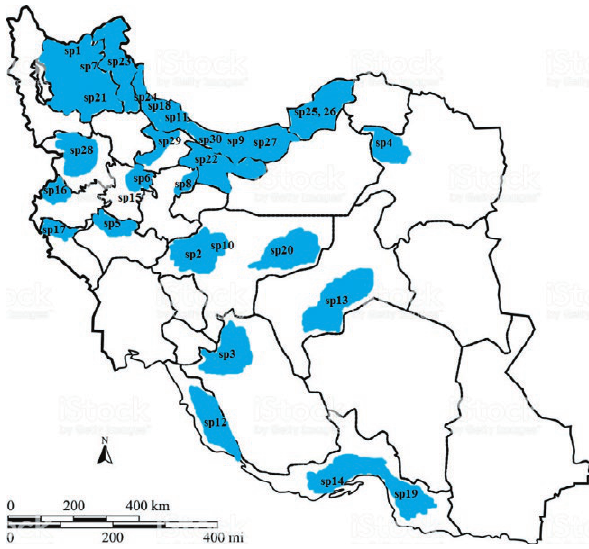
Figure 1. Map of Iran showing sampling localities for Salvia . sp1= Salvia aristata; sp2= S. eremophila; sp3= S. santolinifolia ; sp4= S. tebesana; sp5= S. bracteata ; sp 6= S. suffruticosa ; sp7= S. draco- cephaloides ; sp8= S. hydrangea; sp9= S. multicaulis ; sp10: S. syriaca ; sp11: S. viridis; sp12= S. mirzayanii ; sp13= S. macrosiphon; sp14= S. sharifii; sp15= S. reuterana; sp16= S. palaestina; sp17= S. sclare- opsis; sp18= S. spinose; sp19= S. compressa; sp20= S. sclarea; sp21= S. aethiopis; sp22= S. microstegia; sp23= S. xanthocheila; sp24= S. limbata ; sp25= S. chloroleuca ; sp26= S. virgate; sp27= S. nemorosa; sp28= S. urmiensis ; sp29= S. oligphylla; sp30= S. verticillata.